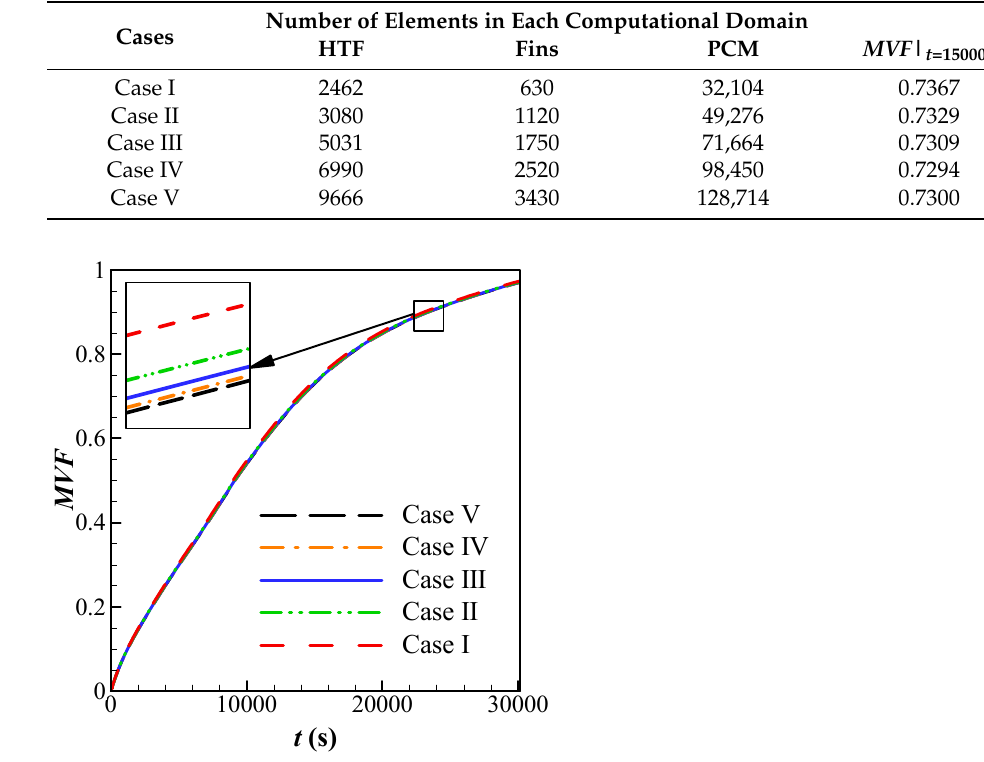
Figure 2. Effect of Grid dependency on the melting volume fraction for case AR = 0.95, α = 0.25 π , and VF na = 0.03.